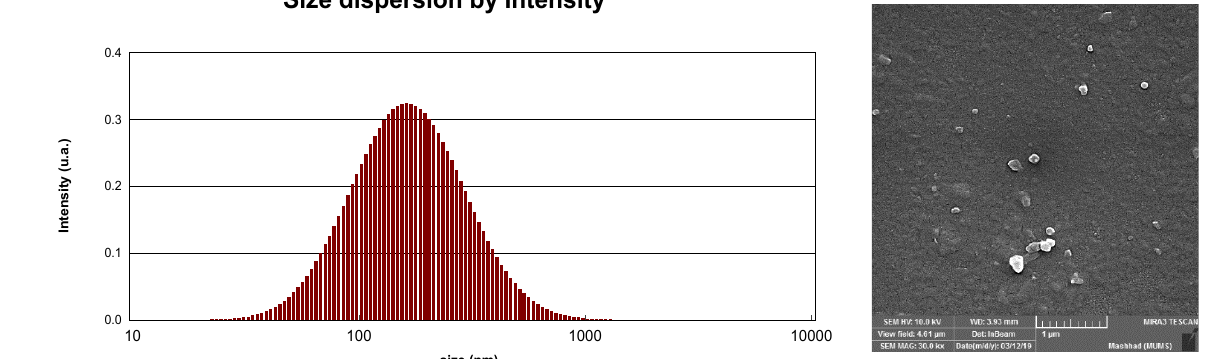
Figure 1. The characteristics of Heracleum persicum essential oil nanoemulsion and anticancer effect of HAE-NE. The dynamic light scattering results revealed that the nanoemulsion size dispersion was 153.64 nm ( left ). The Field Emission Scanning Electron Microscopy indicated the spherical shape of HAE-NE, which was in accordance with particle size data ( right ).